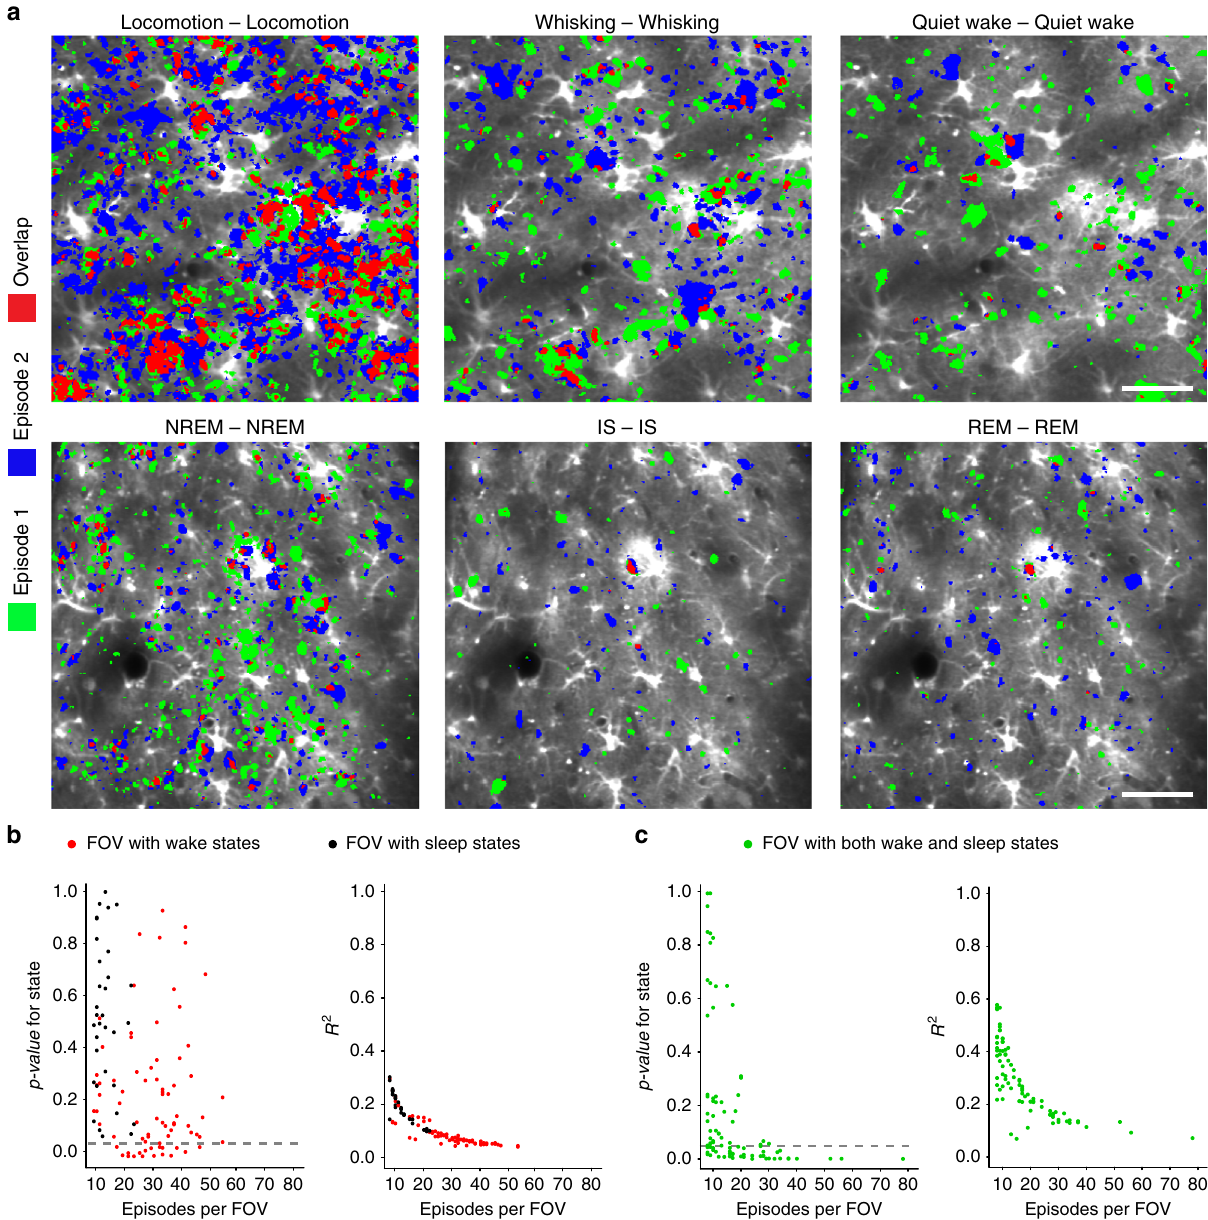
Fig. 4 Spatial distribution of astrocytic Ca 2 + signals across sleep-wake states. a Representative astrocytic Ca 2 + activity maps outlining areas active during episode 1 (green) and episode 2 (blue) of each of the sleep-wake states, and the overlap between the active areas (red). Scale bar 50 μ m. In all 165 FOVs were compared. b Every dot represents a single FOV. Red dots are FOVs with only wakefulness sub-states whereas black dots are FOVs with only sleep sub-states. (Left) The probability, under the null model of no state-speci fi city in activation, of the observed degree of overlap between episodes of different states relative to the degree of overlap between episodes of the same state (locomotion-locomotion, whisking-whisking, quiet wake-quiet wake, NREM-NREM, IS-IS, REM-REM). Only FOVs below dashed line ( p = 0.05) have a signi fi cant effect of state (representing some degree of state-speci fi c overlap in activity). (Right) The degree of overlap within episodes of the same state relative to the total degree of overlap between episodes of same and different states (a high R 2 value indicates that episodes within the same state are very similar, while episodes from different states are very different). c Same as b but for FOVs with both sleep and wakefulness sub-states. n = 6 mice, 165 unique FOVs, 3793 episodes. Statistical analysis by use of permutational multivariate analysis of variance. For details on statistical analyses, see “ Methods ”